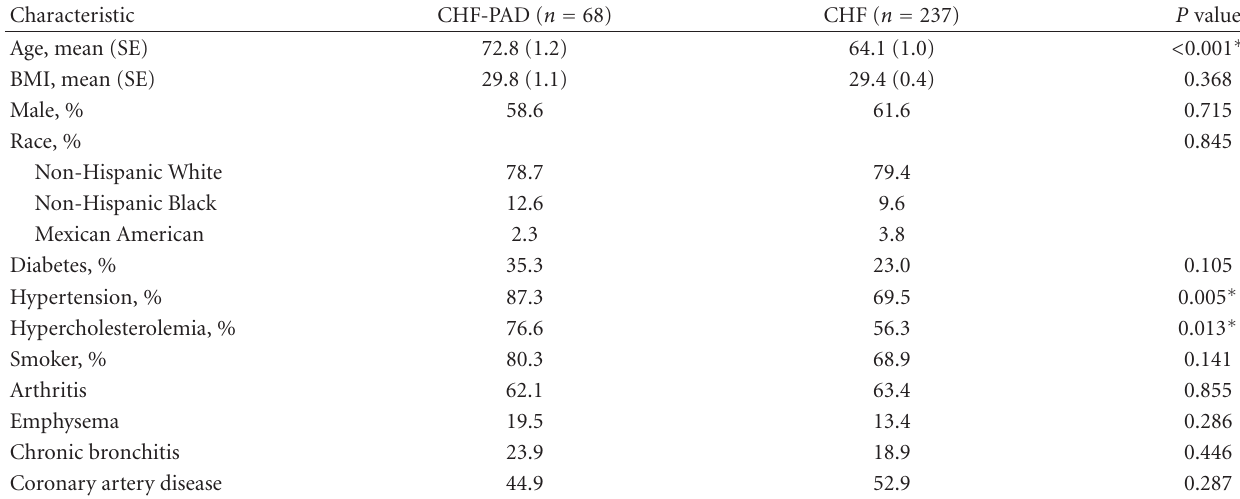
Table 1: Baseline characteristics (CHF patients only).